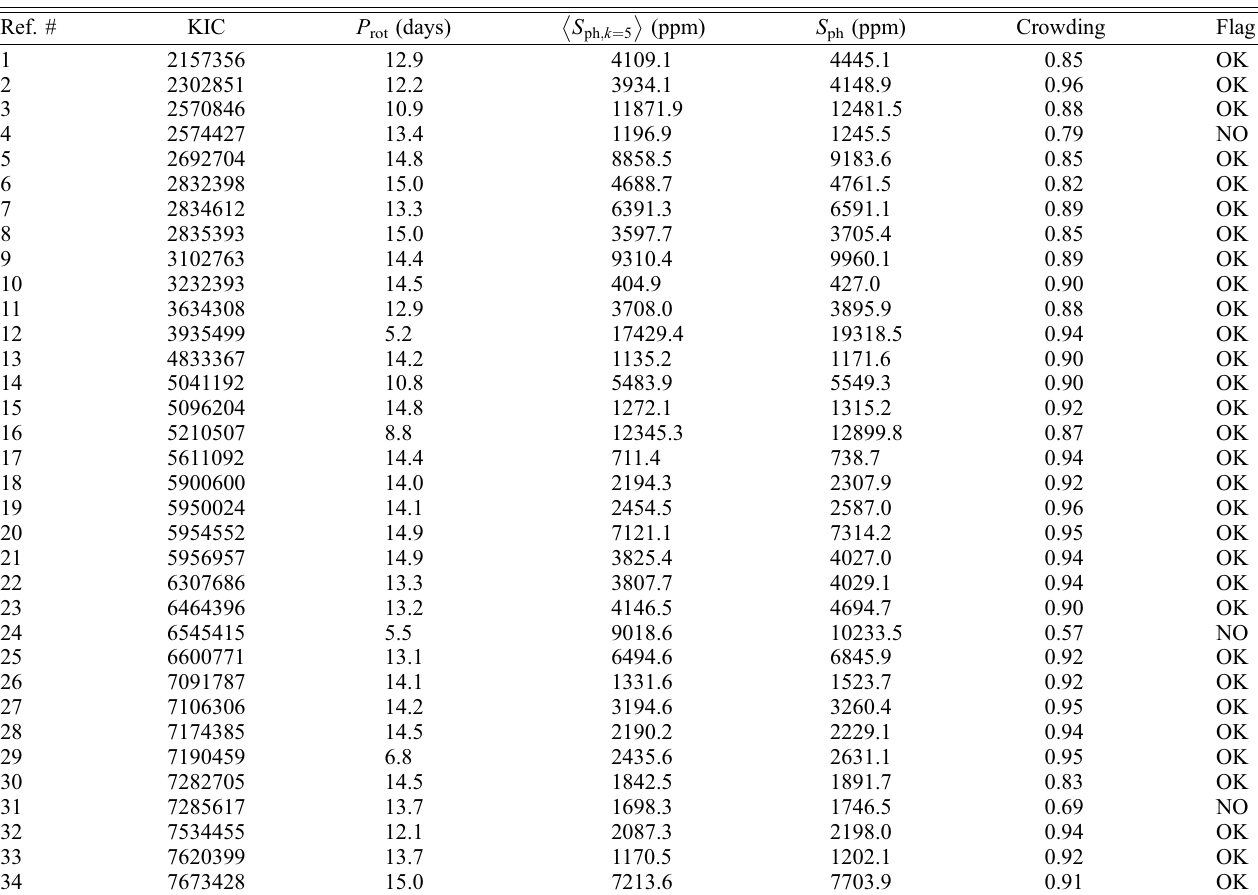
Table 1. List of M dwarfs analysed with the rotation periods from McQuillan et al. (2013), the magnetic indexes S ph ; k (cid:2) (cid:3) for k = 5 and S ph corrected from the magnitude following Jenkins et al. (2010), the crowding, and a flag for possible pollution from a nearby star. Ref. #